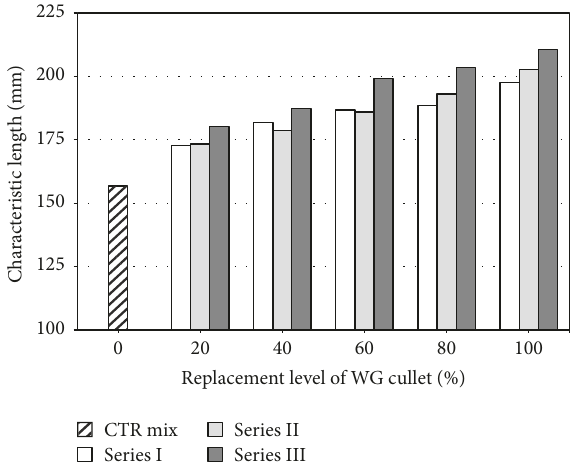
Figure 12: Characteristic length of SCC mixtures at 28 days with respect to WG cullet